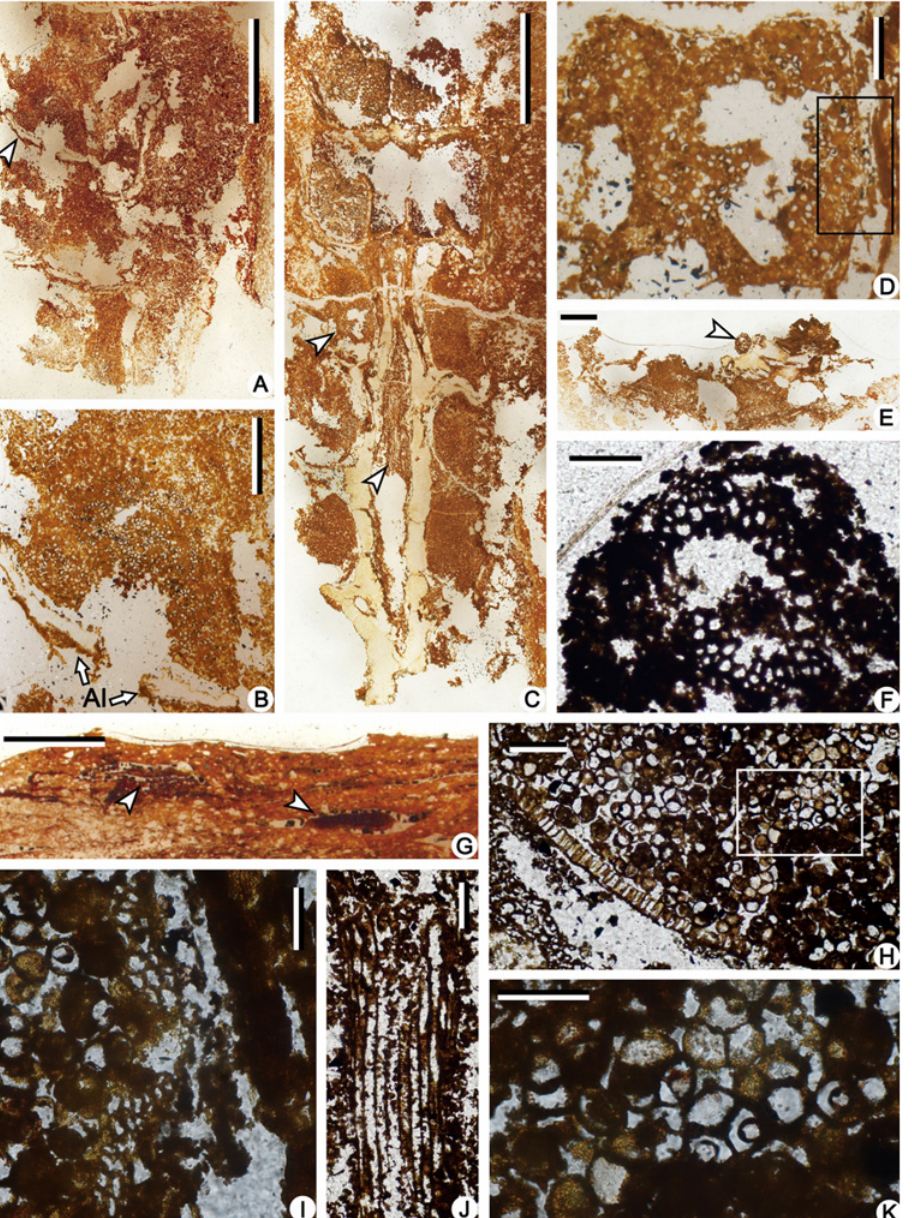
Fig 4. Sections of the permineralized microsporangiate strobilus of Minostrobus chaohuensis in Fig. 3F, under LM. (A) Longitudinal section of strobilus, showing sporophylls and sporangia. Arrow indicating portion enlarged in Fig. 4B. PKUB12189-3-4. Scale bar = 2 mm. (B) Enlargement of Fig. 4A (arrow), showing microsporangium with numerous microspores and alations (Al) of sporophyll. PKUB12189-3-4. Scale bar = 0.5 mm. (C) Radial section of strobilus, showing strobilar axis, sporophylls and microsporangia. Arrows indicating portions enlarged in Fig. 4D and Fig. 4J. PKUB12189-3-3. Scale bar = 2 mm. (D) Enlargement of Fig. 4C (upper arrow), showing sporangium containing microspores and subarchesporial pad. Rectangle indicating portion enlarged in Fig. 4I. PKUB12189-3-3. Scale bar = 0.2 mm. (E) Transverse section of strobilus, showing strobilar axis and microsporangia. Arrow indicating portion enlarged in Fig. 4F. PKUB12189-2-3. Scale bar = 1 mm. (F) Enlargement of Fig. 4E (arrow), showing exarch primary xylem of strobilar axis. PKUB12189-2-3. Scale bar = 0.1 mm. (G) Transverse section of strobilus. Arrows indicating transverse view of sporophylls. PKUB12189-1-4. Scale bar = 1 mm. (H) Transverse section of uniseriate sporangial wall, showing columnar cells and microspores in the sporangium. Rectangle indicating portion enlarged in Fig. 4K. PKUB12189-2-5. Scale bar = 0.1 mm. (I) Enlargement of Fig. 4D (rectangle), showing subarchesporial pad and microspores in sporangium. PKUB12189-3-3. Scale bar = 50 μ m. (J) Enlargement of Fig. 4C (lower arrow), showing xylem strand of strobilar axis and metaxylem tracheids with scalariform thickenings. PKUB12189-3-3. Scale bar = 0.1 mm. (K) Enlargement of Fig. 4H (rectangle), showing microspore tetrads and the inner body. PKUB12189-2-5. Scale bar = 50 μ m.